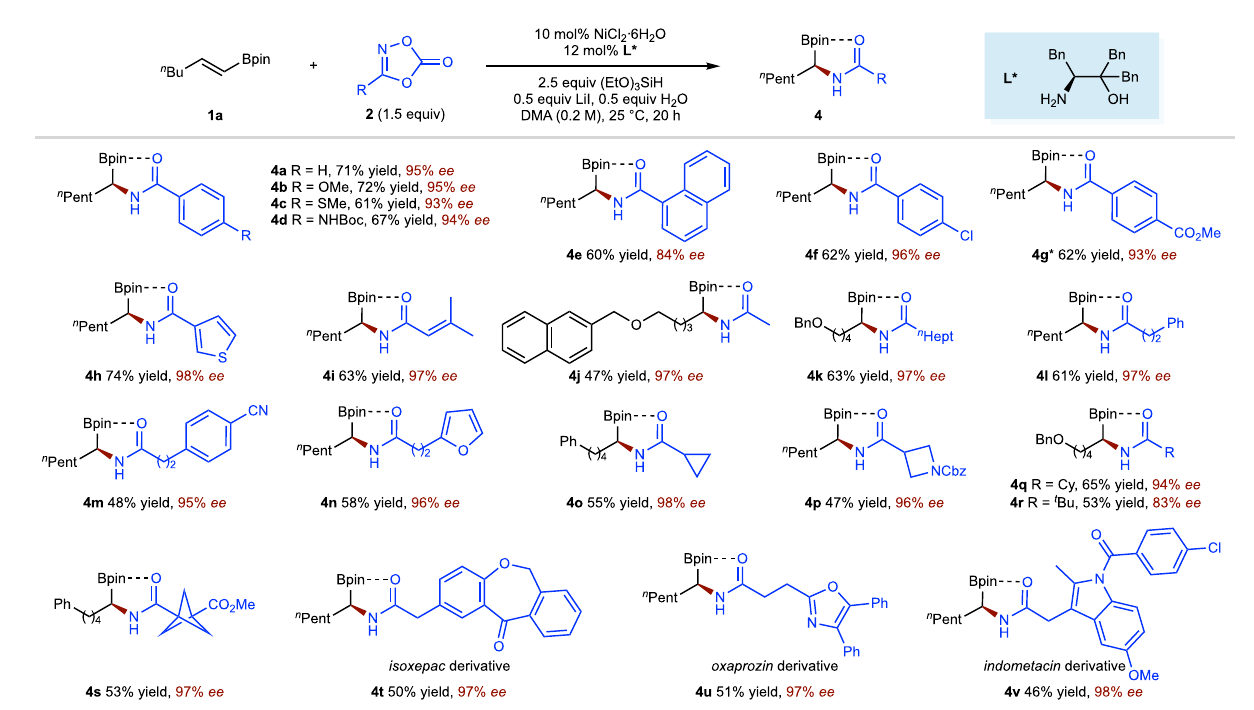
Fig. 4 | Substrate scope of alkene coupling component. Under each product is given yield and enantioselectivities ( ee ) in percent. Yield and ee are as de fi ned in Fig. 3 legend. *MeOH instead of H 2